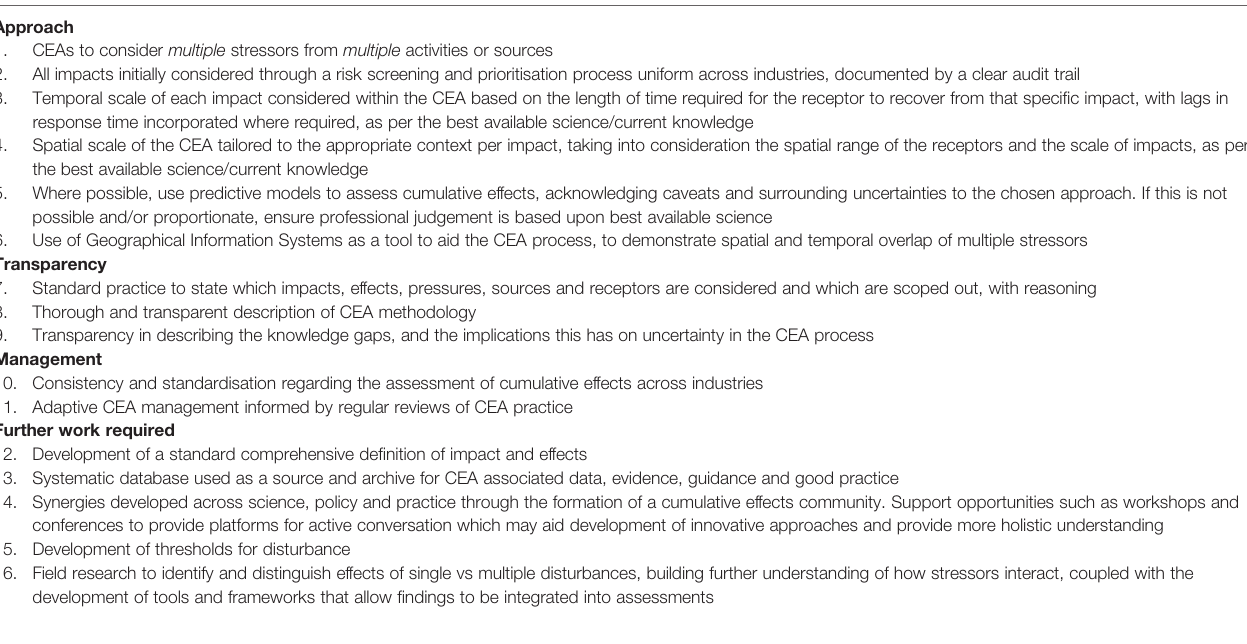
TABLE 2 | Recommendations to improve and standardise Cumulative Effects Assessment